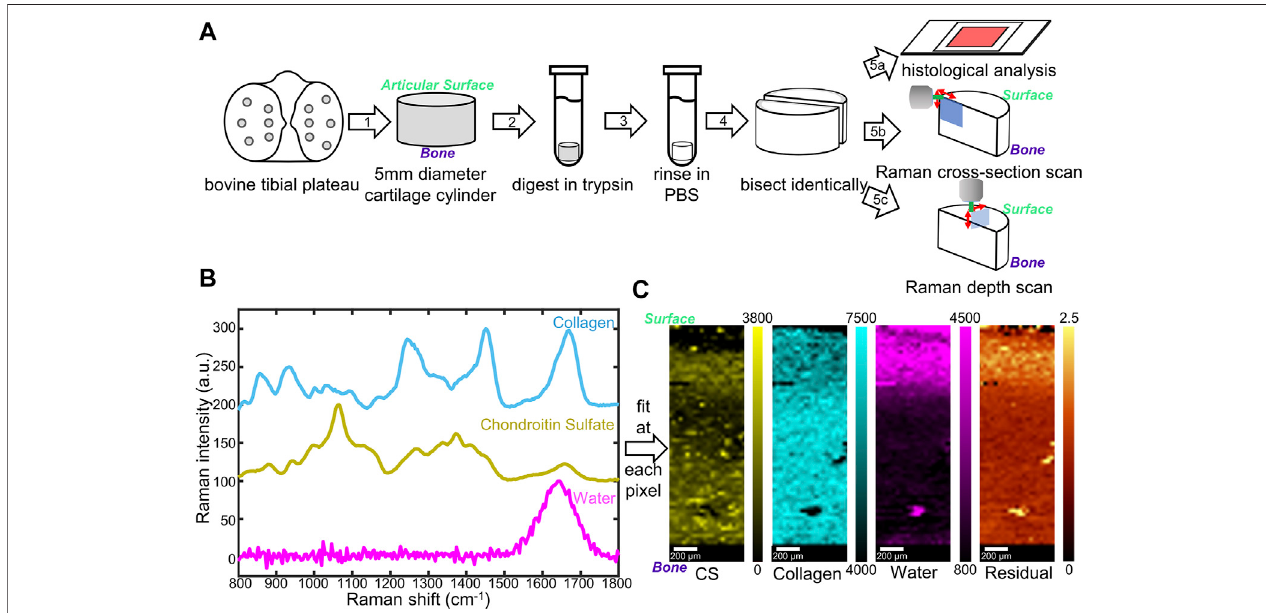
FIGURE1|(A) Schematicdiagramofsamplepreparation and characterization.Cylindricalcartilagesamples(5 mm)werecollectedfromabovinetibial plateau (1), digested in trypsin (2), rinsed (3), and bisected (4) for histological stains (5a) as well as Raman microspectroscopy (5b, c). Two Raman scanning geometries, cross- section scan (5b) and depth scan (5c), have been applied. (B) Reference Raman spectra collected for individual components in cartilage: top (blue) lyophilized rat tail collagen, middle (yellow) shark cartilage chondroitin sulfate (CS) powder; bottom (magenta) deionized water. (C) Representative Raman coef fi cient maps, and residual generated by fi tting the three reference spectra in (B) to spectra obtained from native cartilage